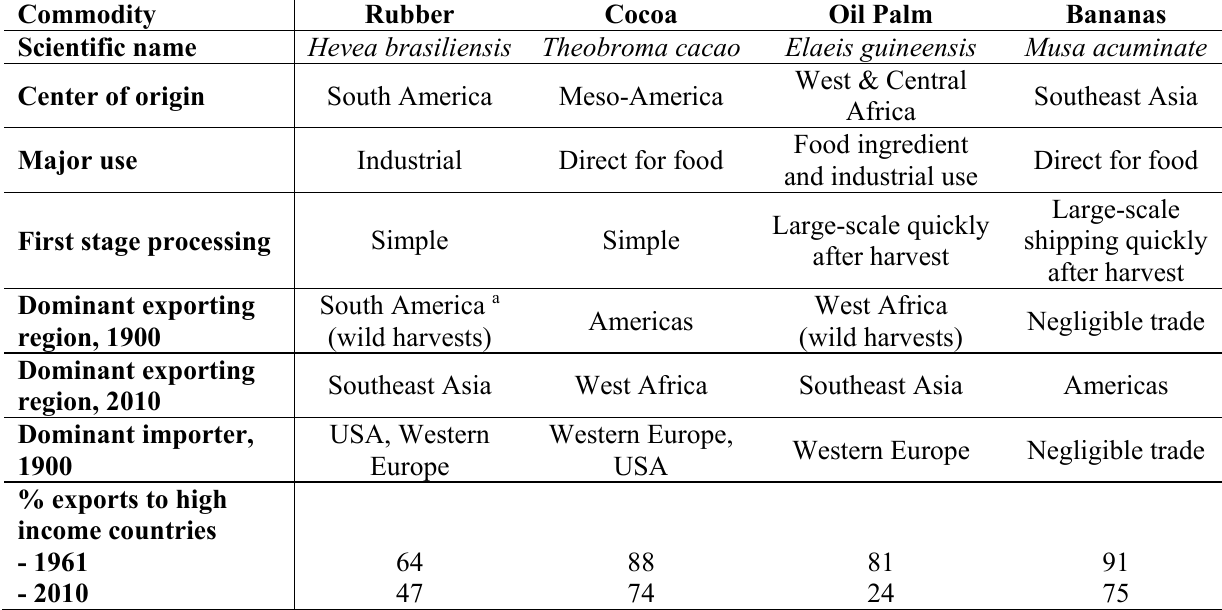
Table 1. Origin and shifts in export production of four tropical commodities in the 20th